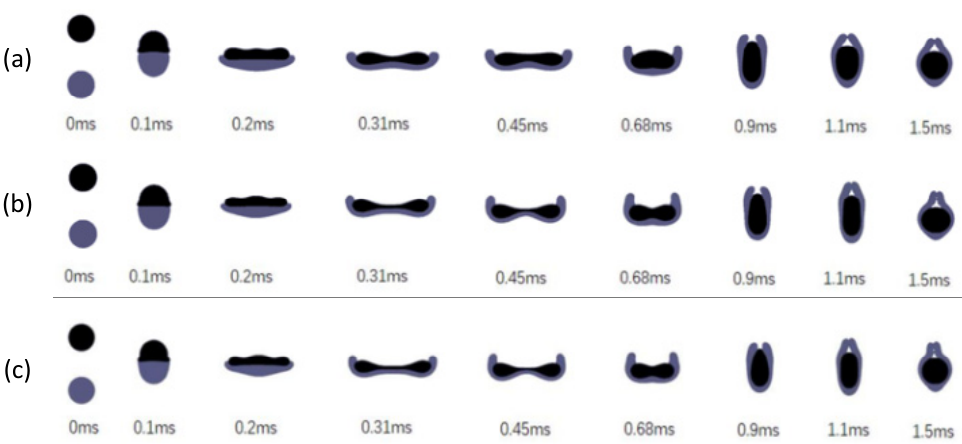
Figure 2. Computed droplet collision processes of the model under the same conditions except for the mesh density: ( a ) coarse mesh, ( b ) moderate mesh, and ( c ) refined mesh.